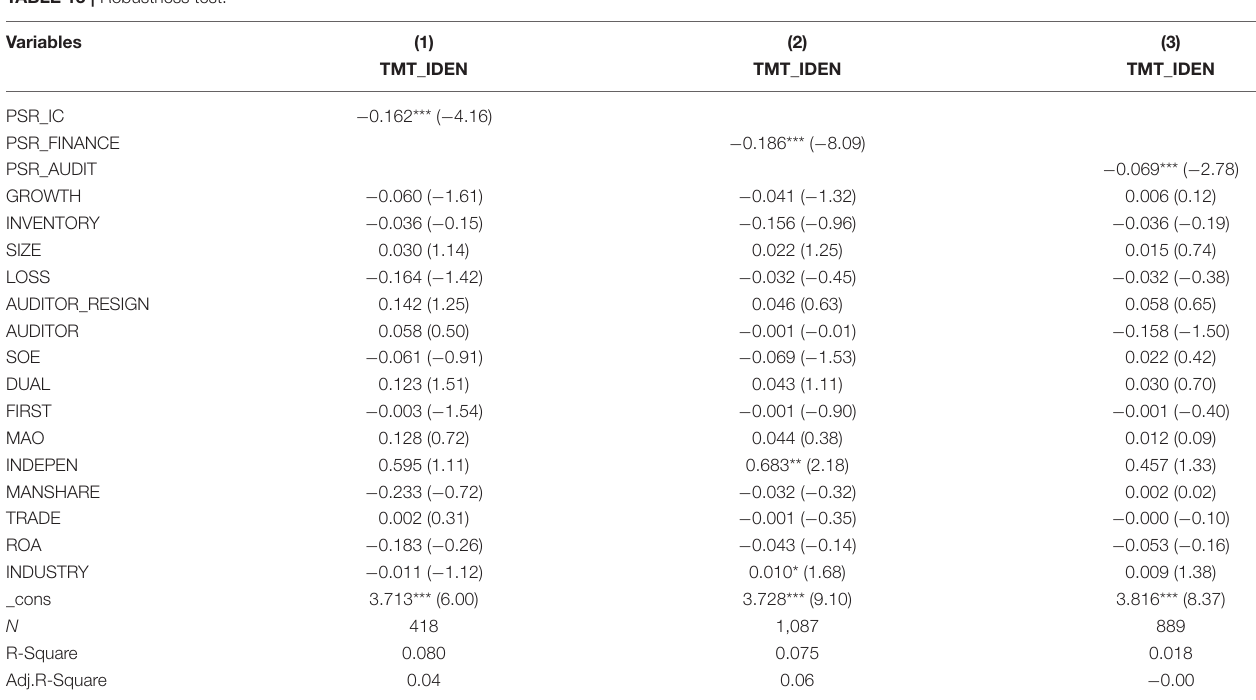
TABLE 13 | Robustness